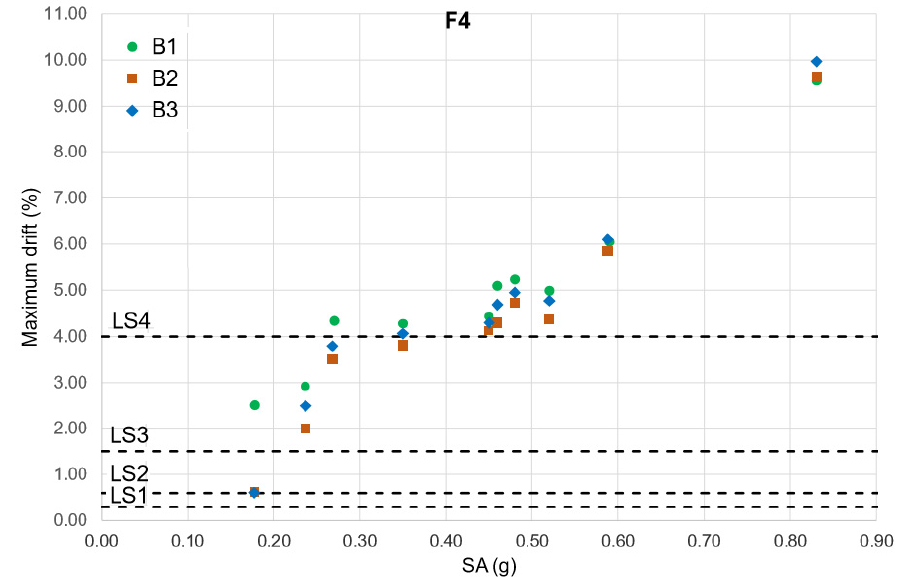
Figure 8. Results: model B1, B2, B3 considering soil F4.